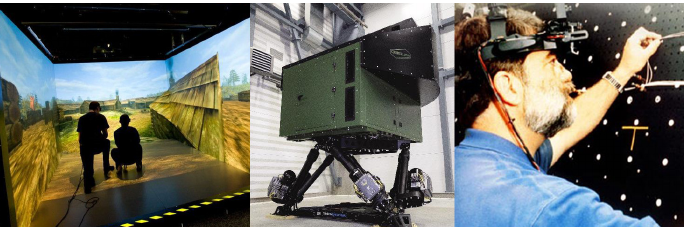
Figure 2. CAVE immersive virtual reality ( left ), professional tank trainer [12] ( middle ), and wiring process of Boening 777 aircraft [13] ( right